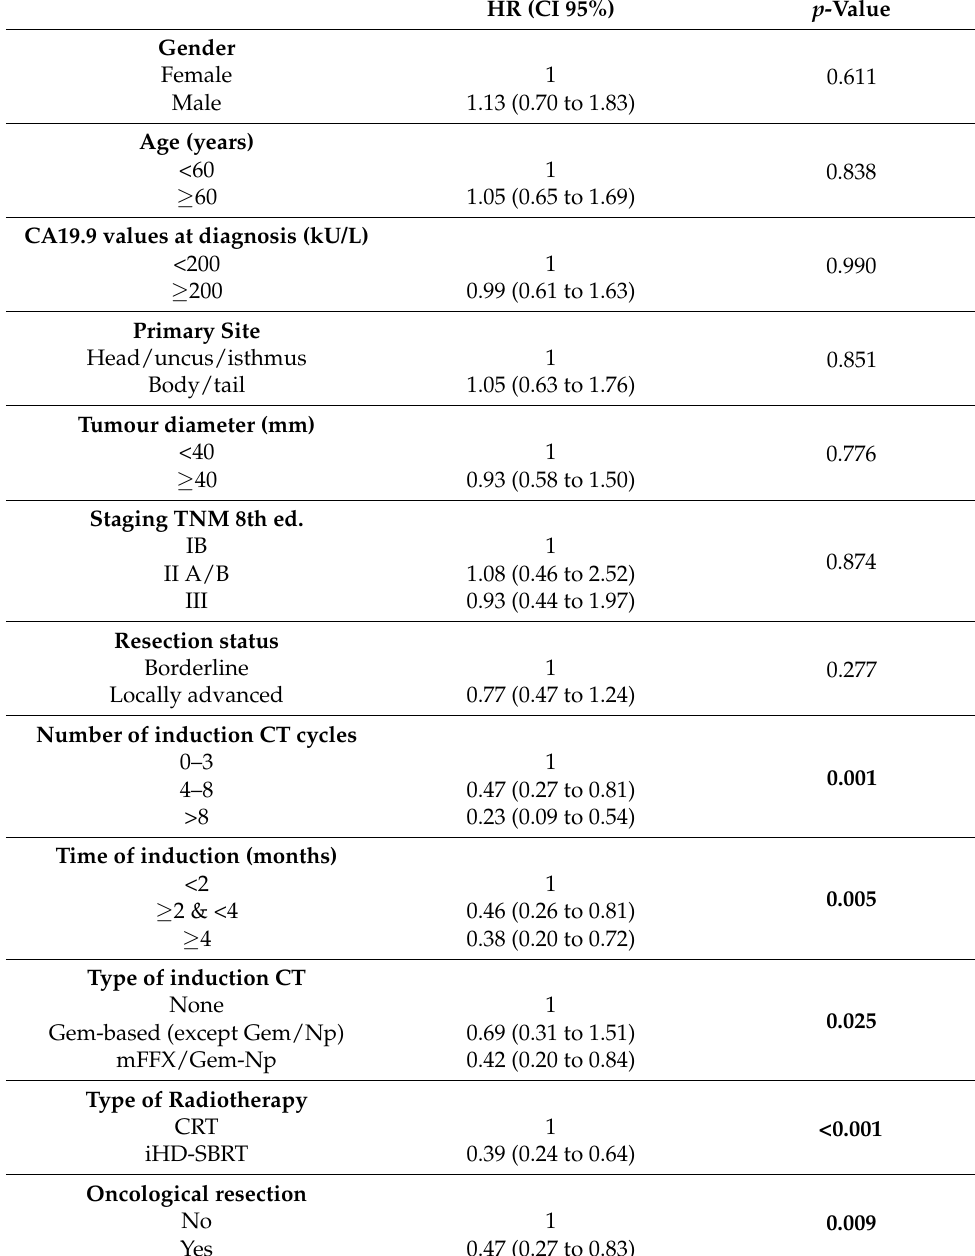
Table 3. Univariate Cox regression analyses ( n =